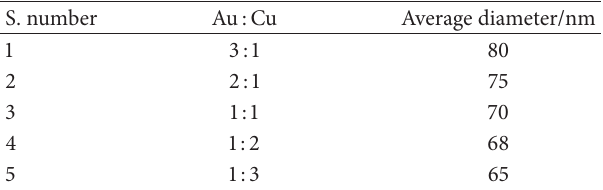
Table5:SizeofnanoparticlescalculatedfromSEM,TEM,andXRD. S.